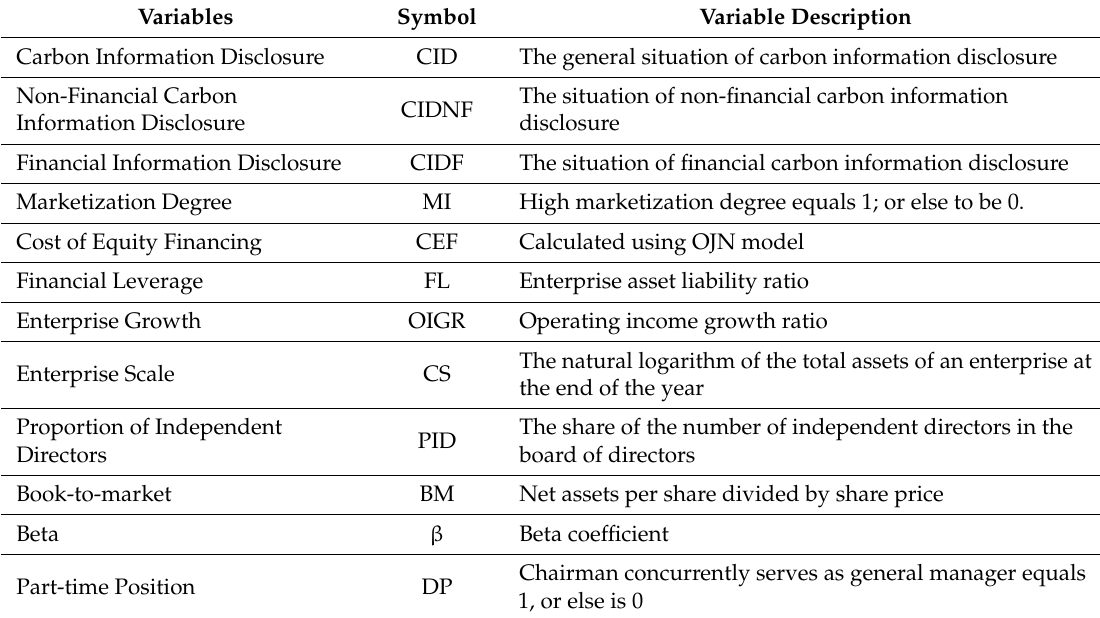
Table 1. Variables specification and